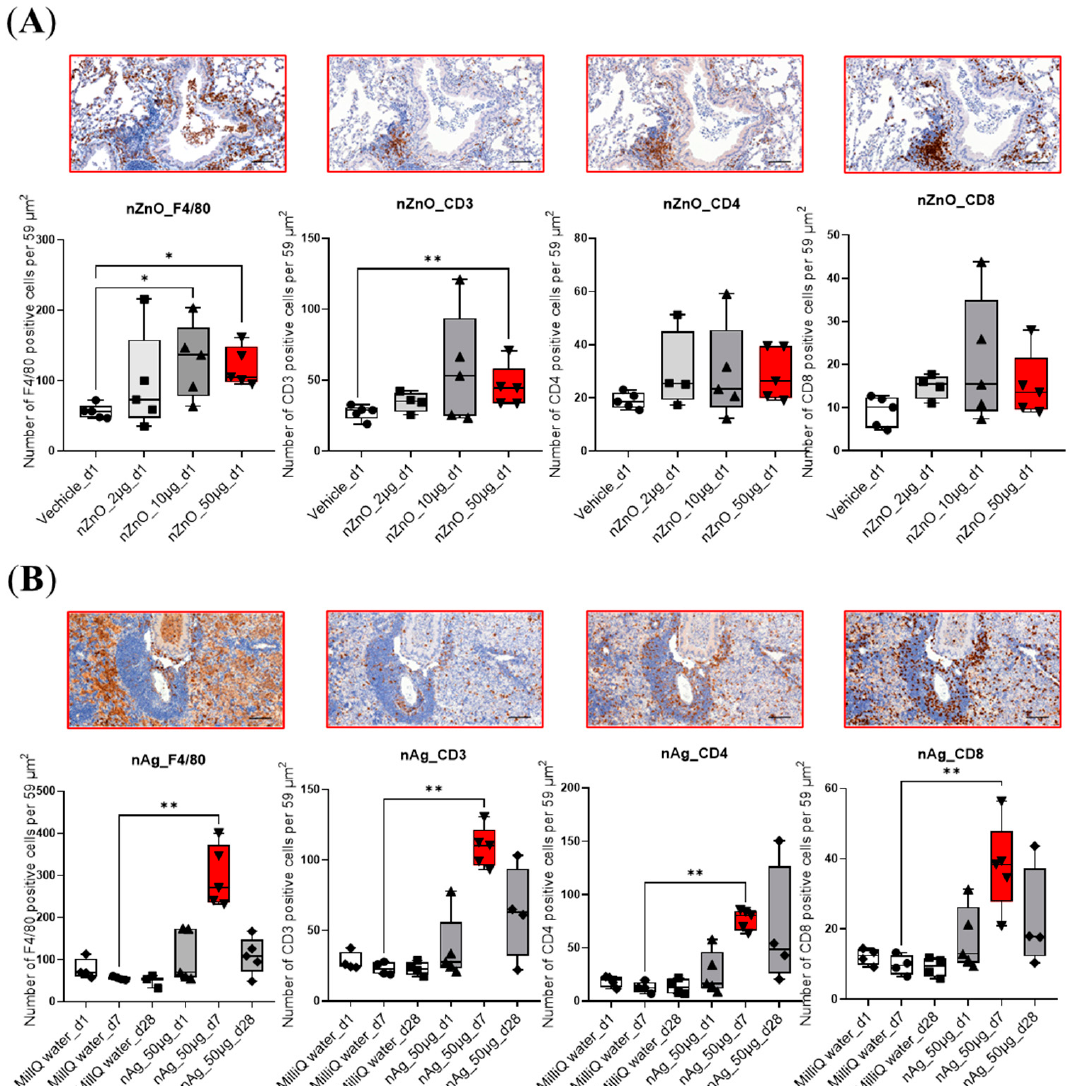
Figure 1. Immunohistochemical staining of mouse lungs exposed to nZnO and nAg for F4/80, CD3, CD4, and CD8. The number of the F4/80-, CD3-, CD4-, or CD8-positive cells per 59 µ m 2 are shown in ( A ) 1 day after exposure to 2, 10, or 50 µ g of nZnO-, and ( B ) 1, 7, or 28 days after exposure to 50 µ g of nAg. Immunohistochemical staining of one representative mouse lung is shown for nZnO 50 µ g at day 1, and nAg 50 µ g at day 7 (both bars indicated by red color). QuPath program was used for cell counting, and Mann–Whitney U-test was used for statistical analyses; * p < 0.05; ** p < 0.001 when compared to control groups. Scale bar: 100 μ m.